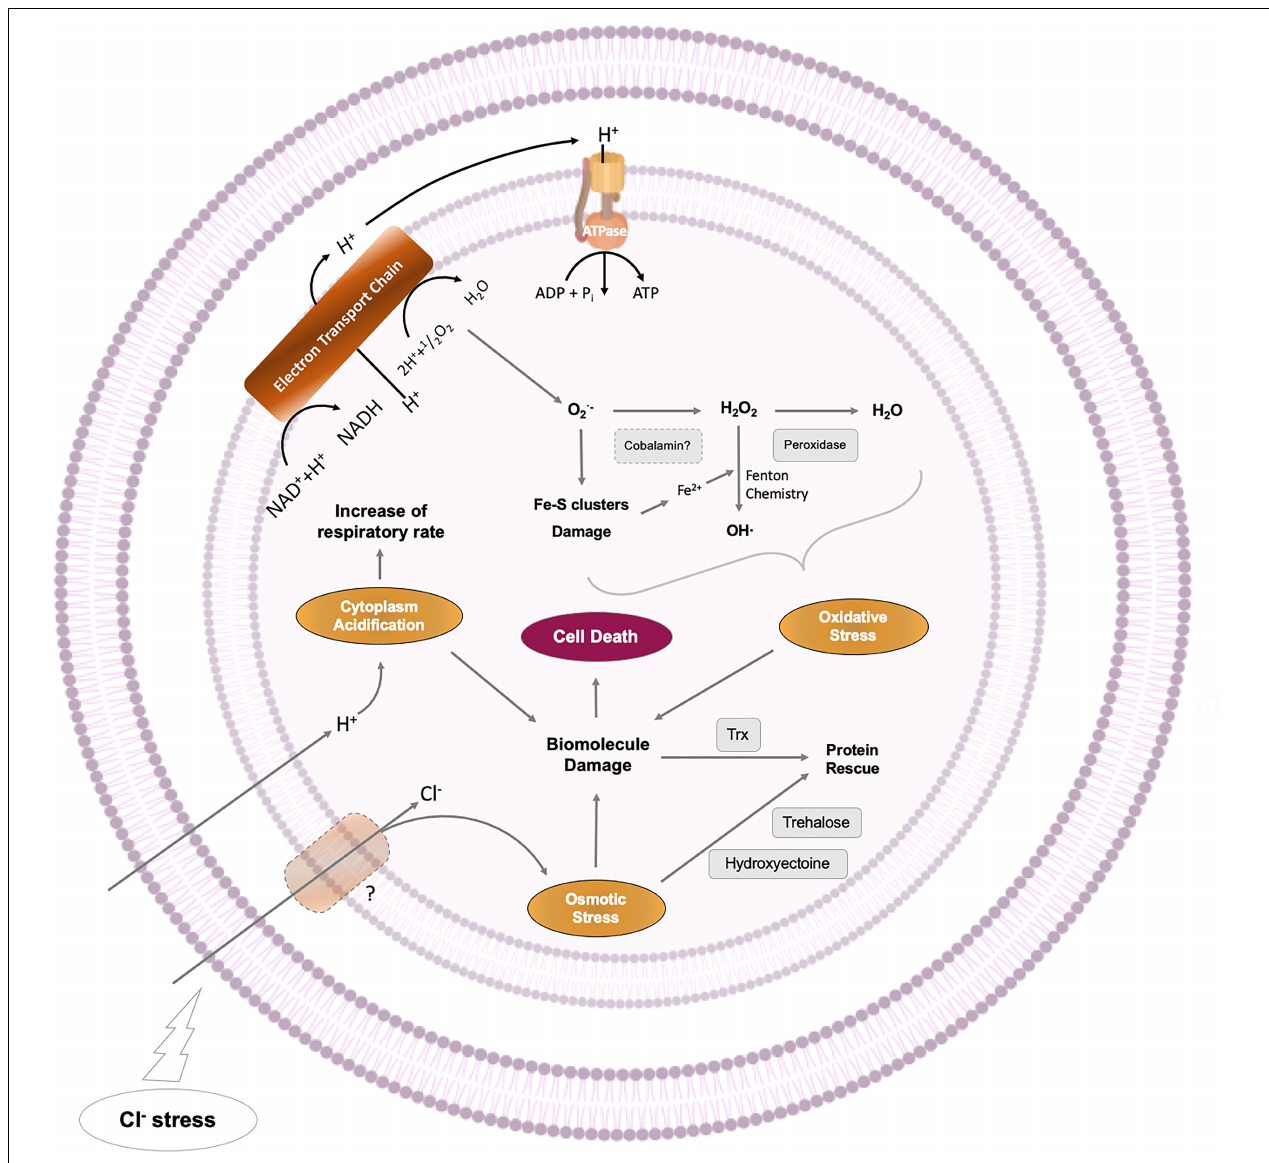
FIGURE 8 | Multifaceted effect of NaCl in L. ferriphilum DSM 14647.